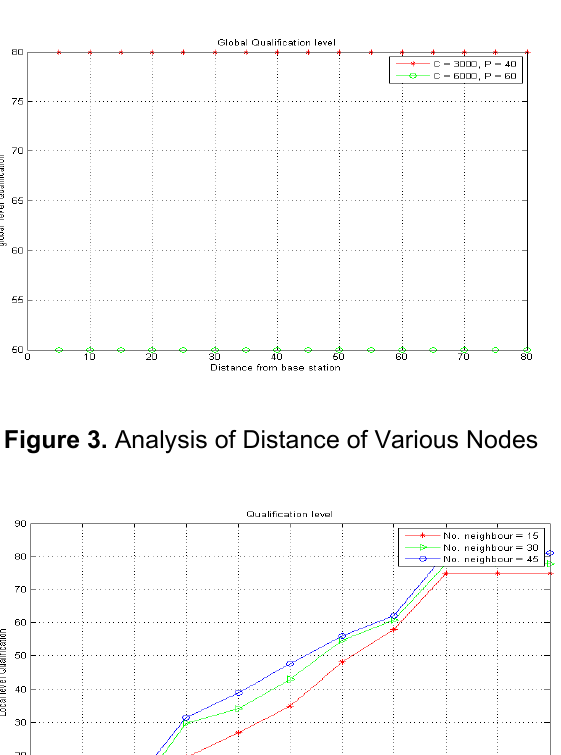
Figure 2. Analysis of Neighbour Node